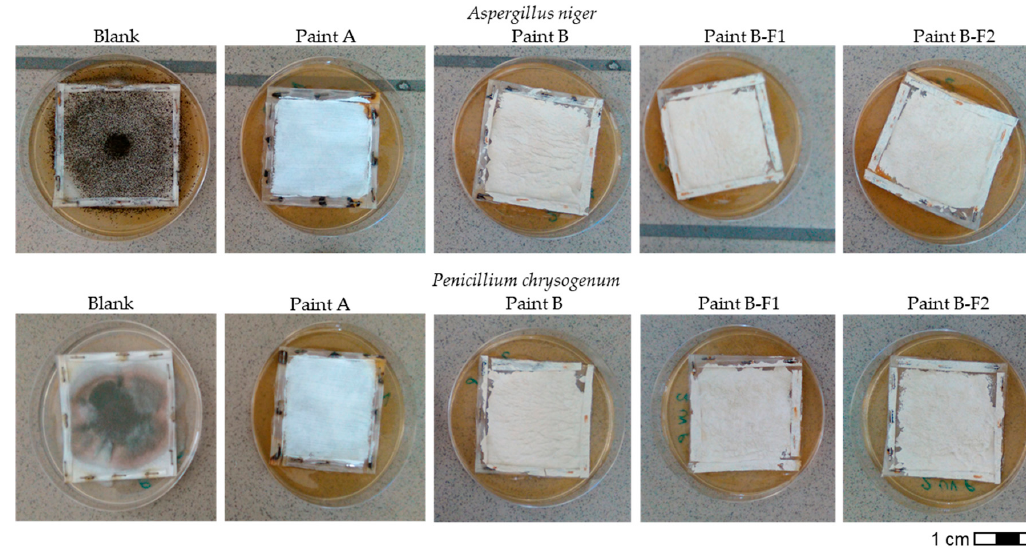
Figure 3. Example of specimens after 4 weeks from the inoculum under test condition 2. Results are the same with and without the previous sterilization of the specimens. All paints appear without fungal colonization.